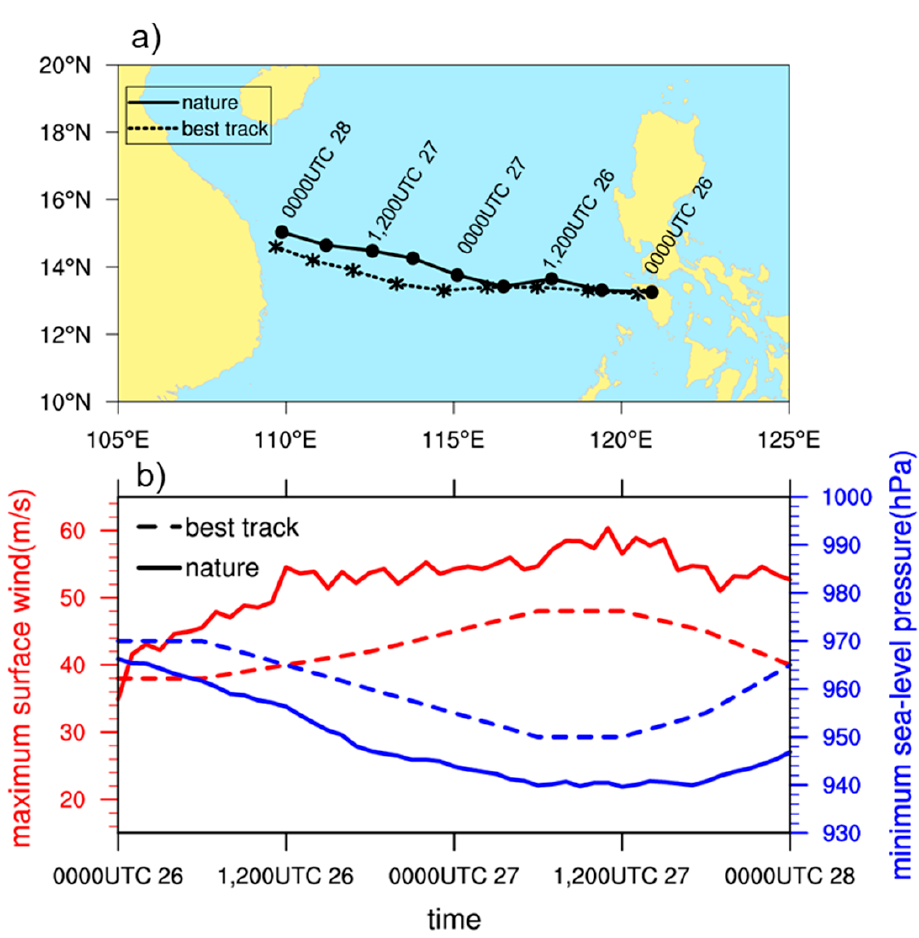
Figure 2. The track ( a ) and intensity ( b ) of nature run (solid line) and CMA best track (dashed line) for TC Molave.